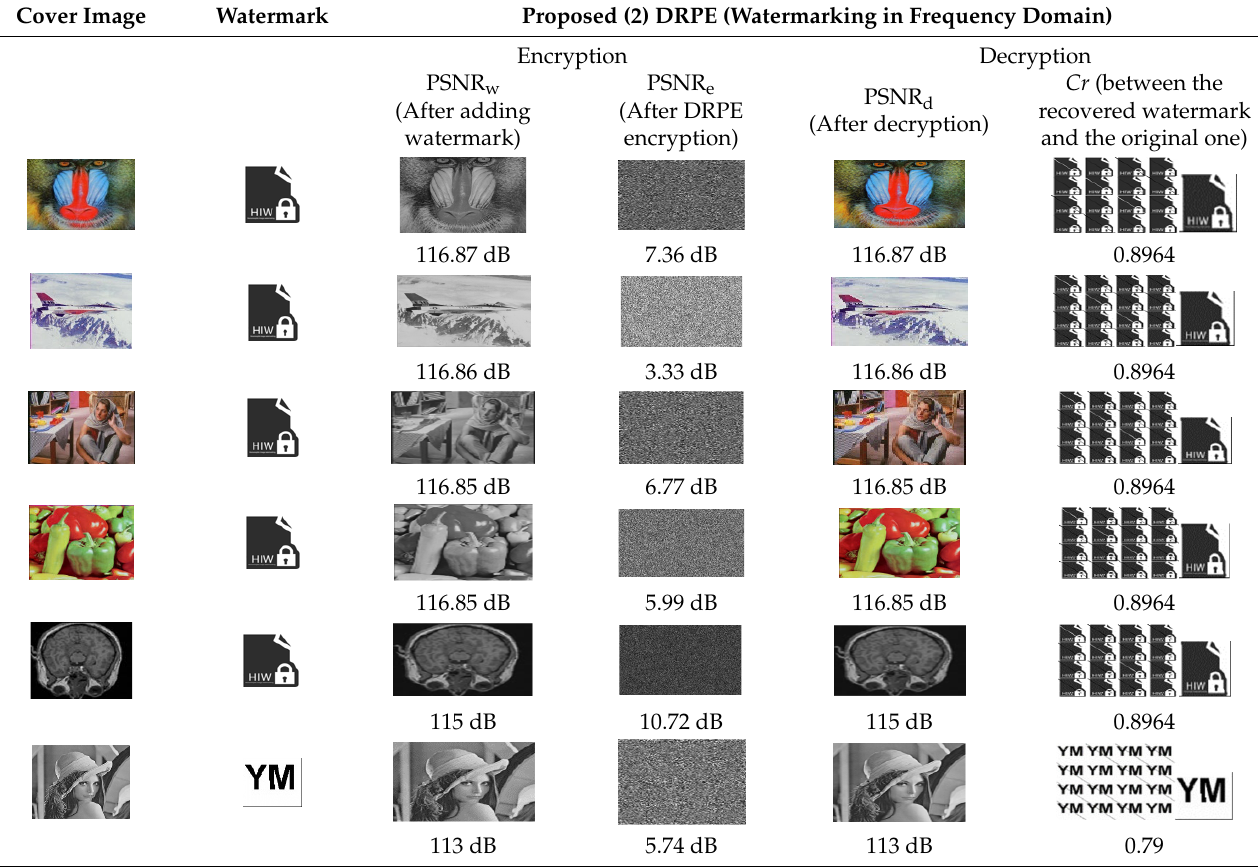
Table 4. Results of the second proposed technique based on